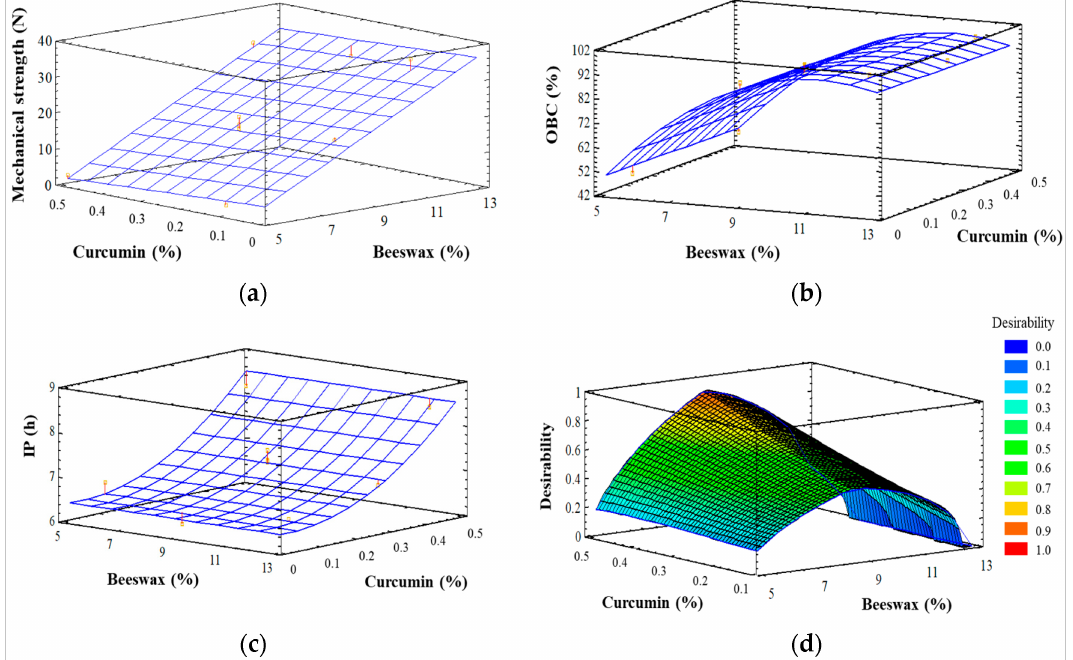
Figure 1. RSM graphics showing the combined e ff ect of concentration of beeswax and curcumin in OGCur on ( a ) mechanical strength, ( b ) oil binding capacity (OBC), ( c ) induction period (IP), ( d ) desirability